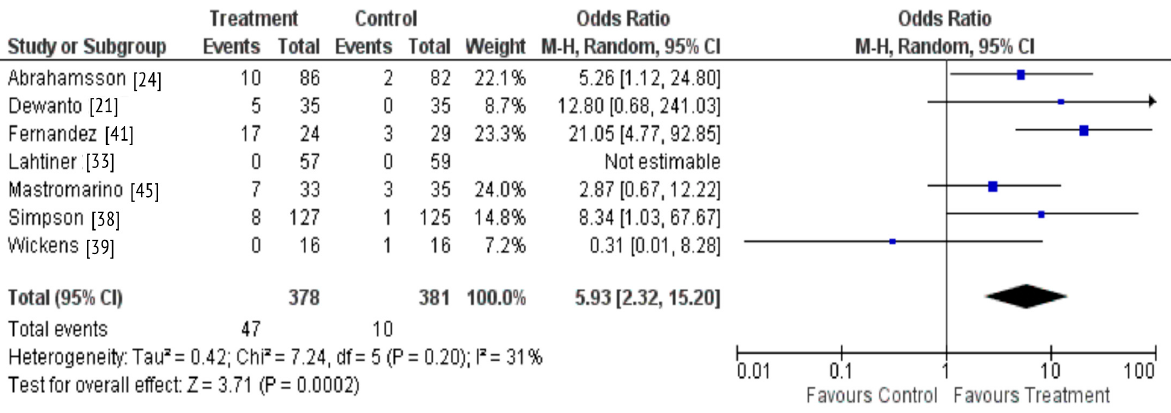
Figure 5. Probiotic supplementation and colonization of the breastmilk microbiota. There were three studies that included lactating women either at risk of, or suffering from lactational mastitis [41,42,44]. Overall, all three studies demonstrated that maternal supplementation with Lactobacillus probiotic administered during pregnancy and/or lac- tation reduced Staphylococcal counts in the breastmilk of supplemented women. In a Span- ish RCT ( n = 108), where women were administered 9log 10 CFU of Lactobacillus salivarius , there was a small but significant difference in mean Staphylococcal bacterial counts in the milk samples from healthy women who had received the probiotic compared to healthy women in the placebo group (0.19 [95% CI 0.09–0.30] log 10 CFU/mL) [41]. The remaining two studies found significantly lower levels of Staphylococcus subspecies in the breastmilk of women treated with the probiotic during lactation [42,44]. Of these, a further study conducted in Spain ( n = 291), administered 3 × 10 9 CFU of Lactobacillus fermentum for 16 weeks to the intervention group. This group observed a reduction by 48%; ( P = 0.013) of Staphylococcus subspecies amongst healthy women and a greater reduction by 58% ( P = 0.065) in women with diagnosed mastitis. Overall, at the end of the intervention, the bac- terial load was lower in the breastmilk of women in the probiotic group compared to the control group ( P = 0.025) [44]. A similar result was reported in a smaller Spanish study (n=20) where the intervention group was administered 200mg of 10log 10 CFU of a multiple strain probiotic for 4 weeks. At the end of the study, the intervention group had a bacterial count of 2.96 log 10 CFU/ml which was significantly lower than in the control group at 4.79 log 10 CFU/ml ( P = 0.002) [42]. Another Spanish study ( n = 148), included women suffering from breast pain and elevated milk bacterial counts, not associated with acute mastitis and also reported a significant decrease in Staphylococcus load in the intervention com- pared to the control group ( P = 0.045) [43]. Notably, treatment with 3 × 10 9 CFU of Lacto- bacillus fermentum for 3 weeks significantly reduced Staphylococcus load in the breastmilk ( P = 0.011). A Norwegian RCT ( n = 252), found no significant effects of supplementation with a multiple strain probiotic administered 4 weeks before delivery to 3 months after birth on the alpha or beta diversity of the breastmilk microbiota [38]. However, this study indi- cated that the supplement may have a positive influence on the stability of the breastfeed- ing-associated microbiota (RR of stable breastfeeding-associated microbiota after probi- otic supplementation: 2.37, 95% CI 0.94–5.97, Fisher’s exact P = 0.050). 3.4. Prebiotics The effects of prebiotic supplementation on infant bacterial counts were investigated in two studies conducted in Japan and Germany [31,46]. In the study based in Germany, with women receiving prebiotics; galactooligosaccharides (GOS) and long-chain fructooli- gosaccharides (lcFOS) or a placebo from 25 weeks’ gestation until delivery ( n = 48), no